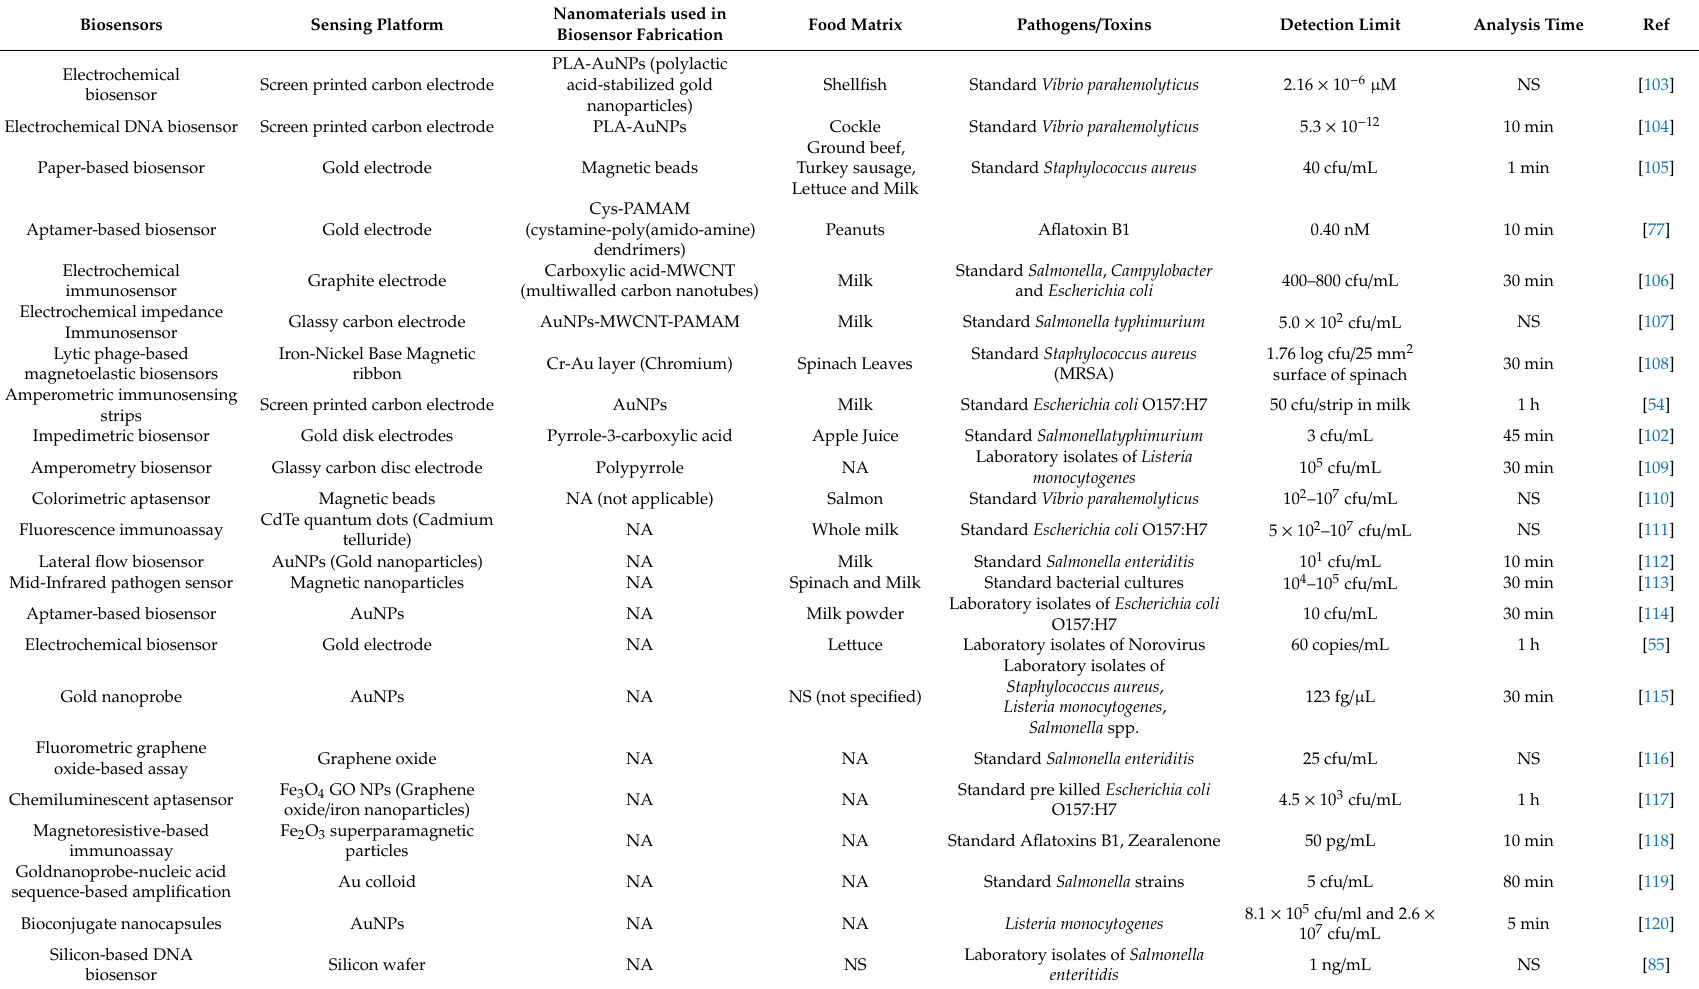
Table 4. Types of nanomaterials used in sensor fabrication for foodborne pathogens and their toxins